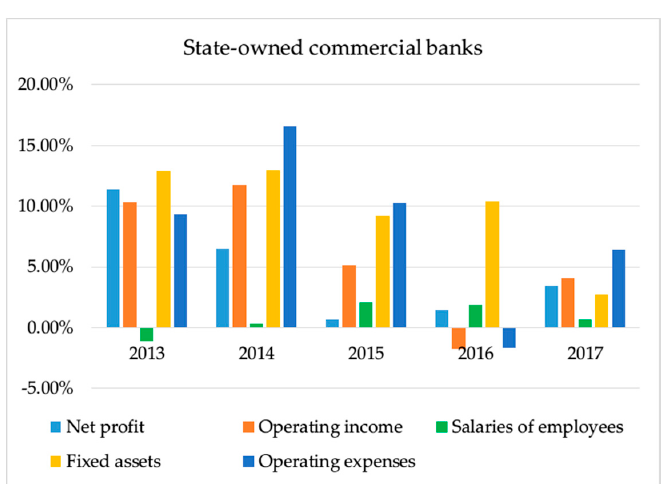
Figure 6. The trends of inputs and outputs (2012–2017).